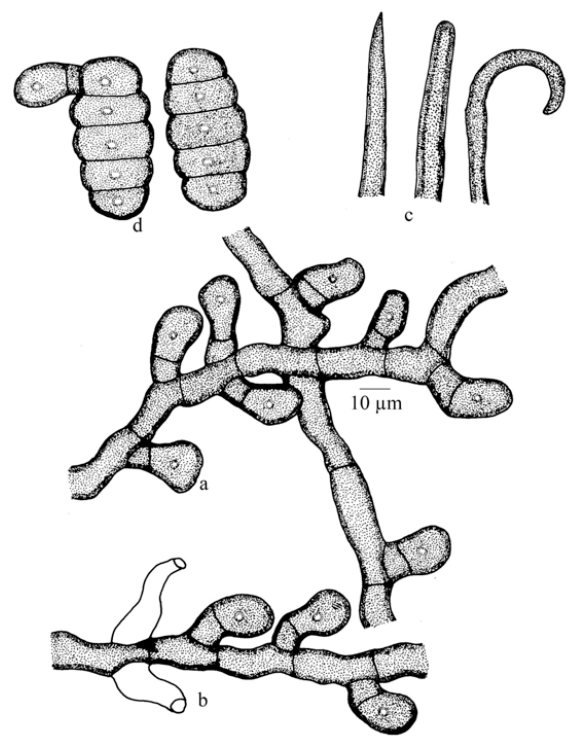
(Fig. 15) urn:lsid:indexfungorum.org:names: 807707